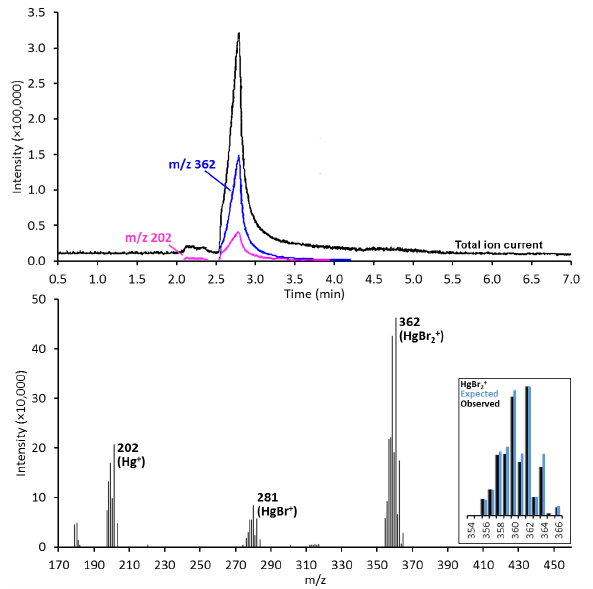
Figure 4. Chromatogram (above) and mass spectrum at 2.92min (below) of HgBr 2 emitted from a permeation tube. The Y axis shows the mass spectrometer’s ion current intensity. The box on the bottom right compares the expected HgBr + mass spectrum (from 2 de Laeter et al., 2004) to the observed spectrum.